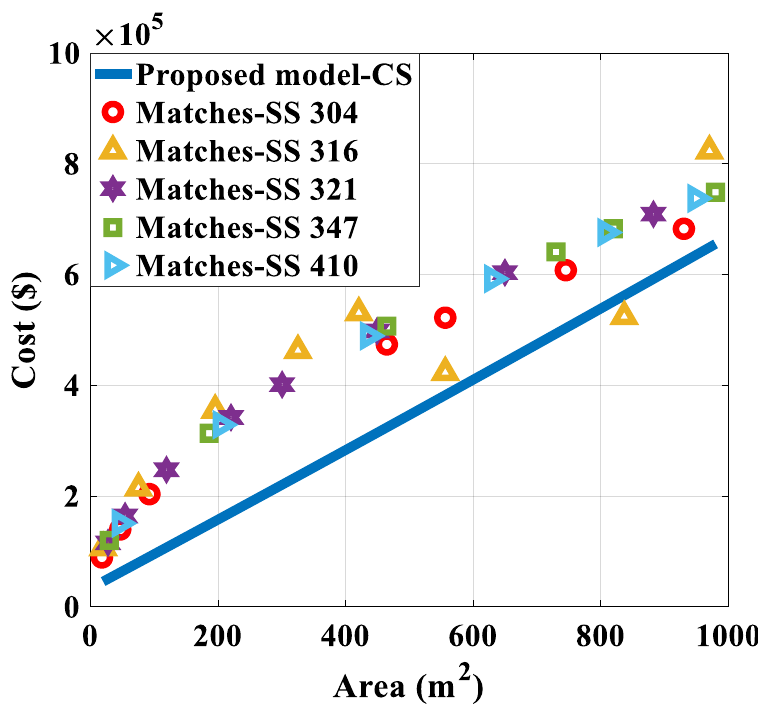
Figure 7. Air cooler cost against area [48].